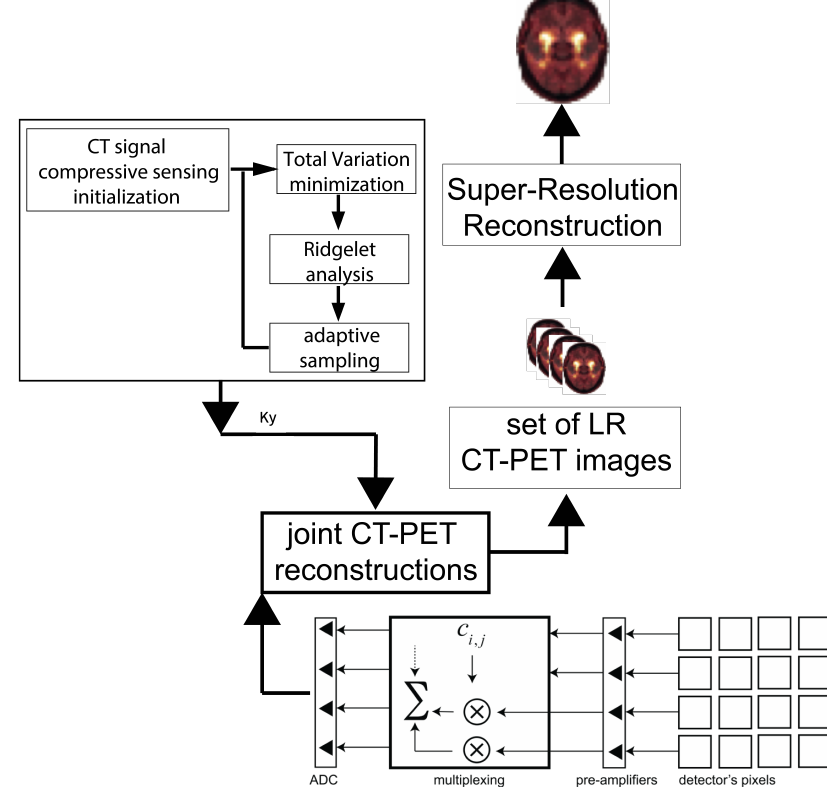
Figure 1. The CT/PET inputs utilising their joint